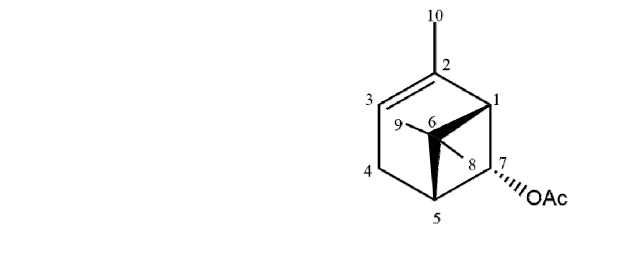
Figure 1. Structure of (+)-( E )-chrysanthenyl acetate.